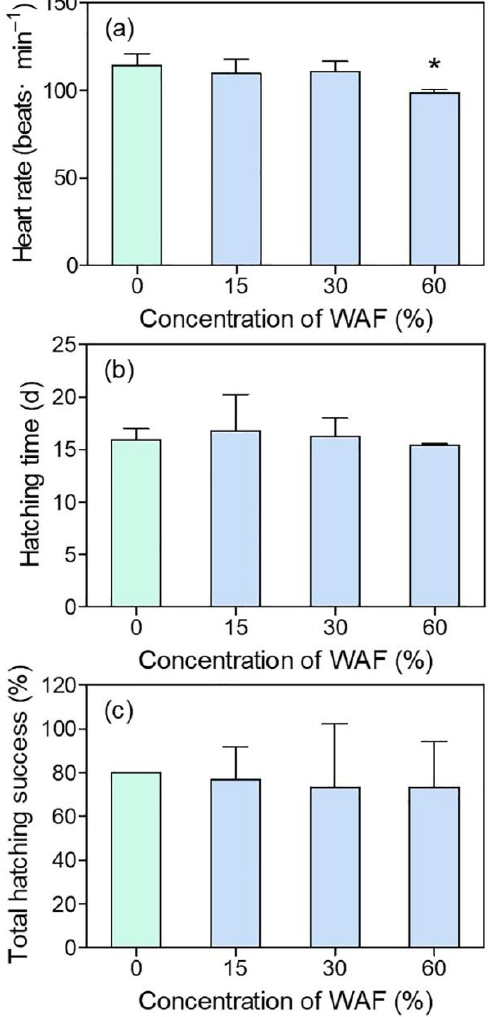
Figure 4. Heart rate ( a ), hatching time ( b ), and total hatching success (%) ( c ) of marine medaka embryos in chronic test ( n = 3). The symbol * indicates significant difference of the treatment compared to the control ( p < 0.05).